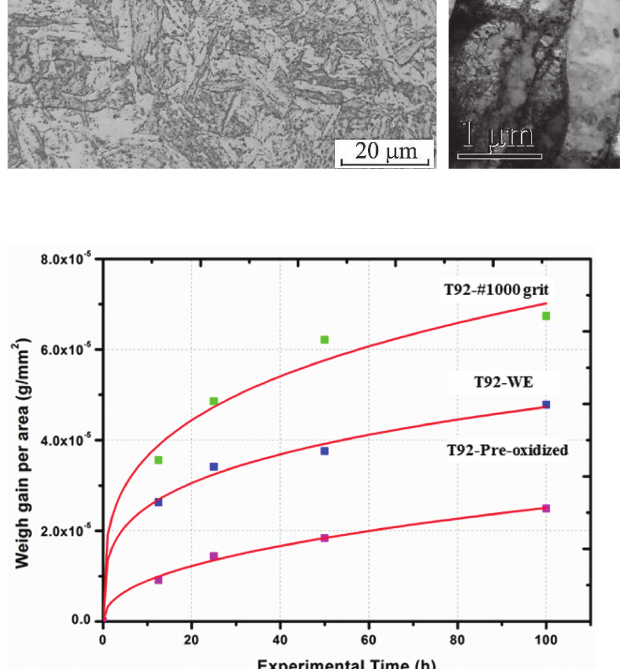
Figure 3: Oxidation kinetics of T92 with different surface finishes in steam.